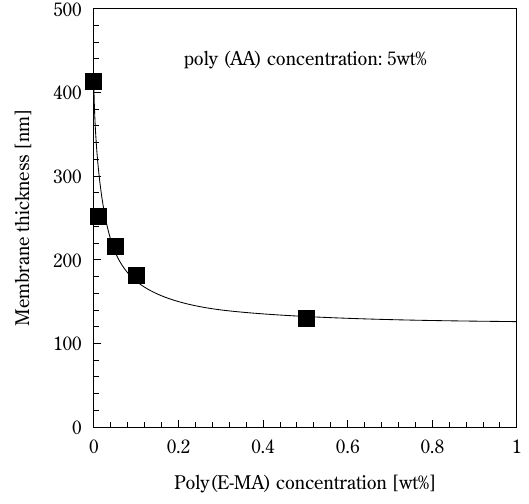
Relationship between membrane thickness and poly(E-